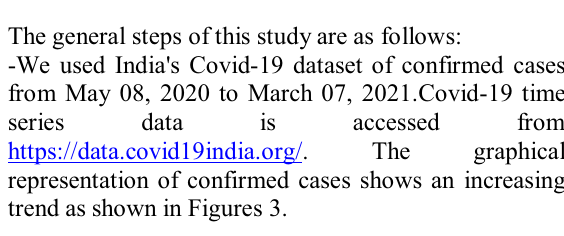
Fig. 3. Confirmed cases in India